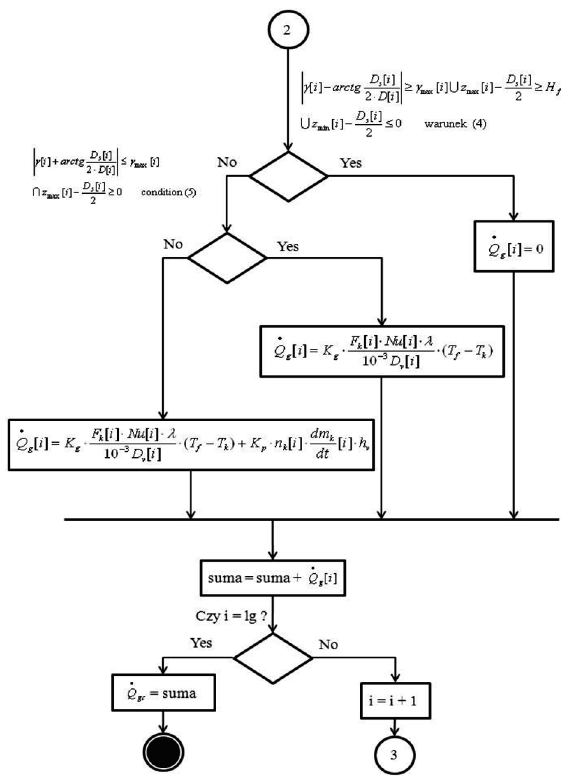
Figure 3. Flowchart of a main computer program (part 2)